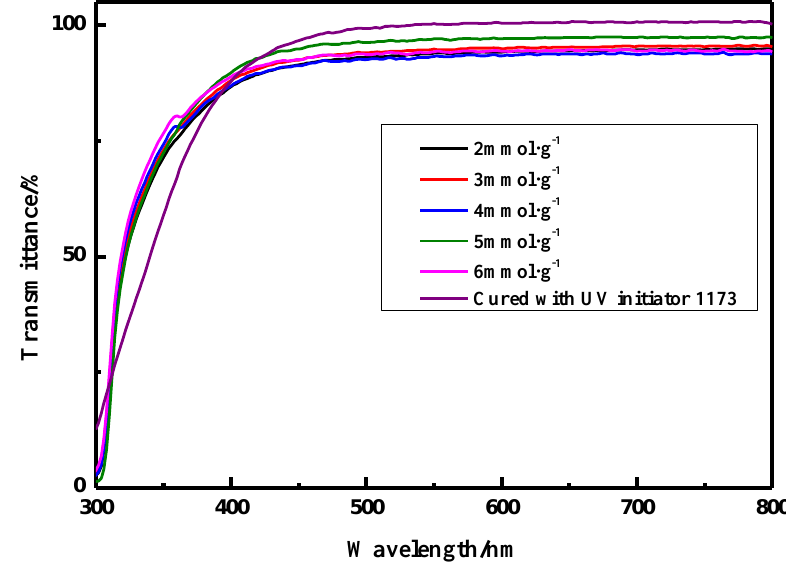
Figure 3. Photos of coatings prepared in Table 3 and the coating cured with UV initiator 1173.